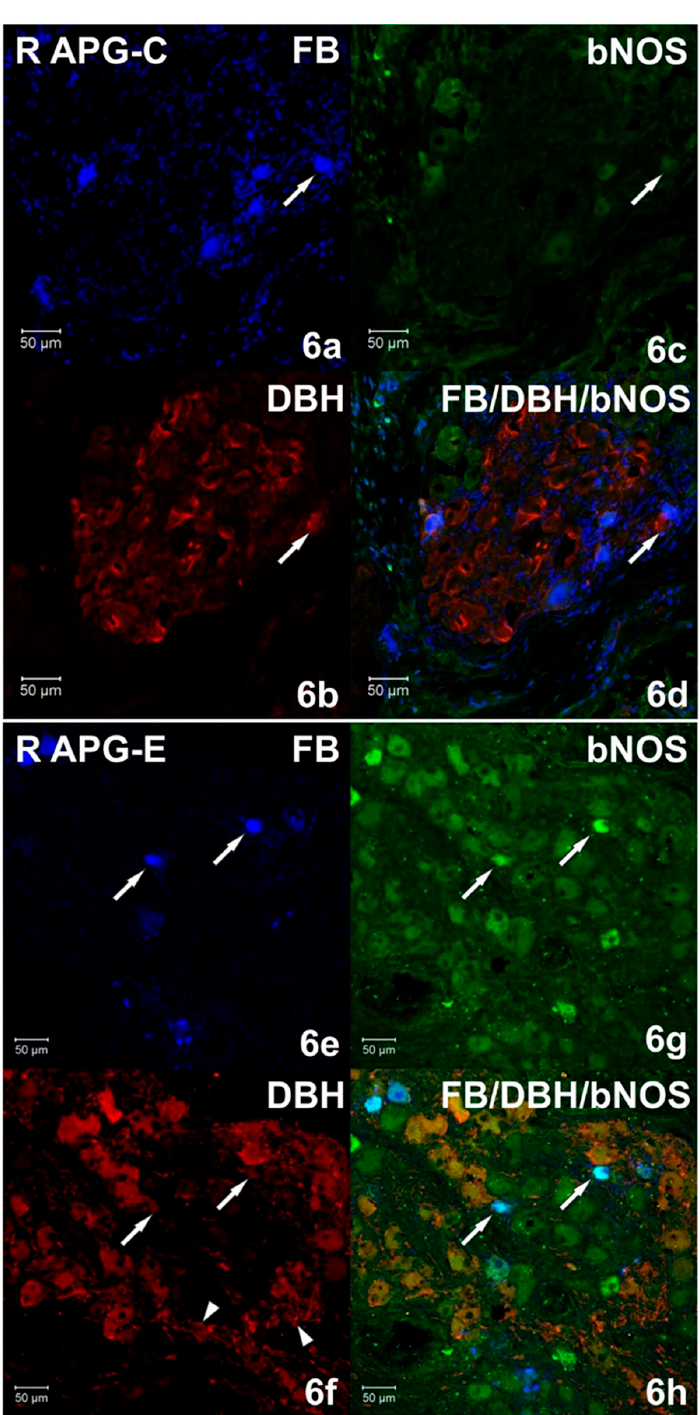
Figure 6. ( a – d ) Confocal laser scanning microscope images showing a section of the right (R) APG from the control (C) group. FB+ neurons ( a ) double-stained ( d ) for DBH ( b ) and brain nitric oxide synthase (bNOS) ( c ). The arrow marks an FB+ cell containing DBH but not bNOS. The images were taken from blue, green and red fluorescent channels. Blue, green and red channels were digitally superimposed. Scale bar = 50 µm. ( e – h ) Confocal laser scanning microscope images showing a section of the right (R) APG from the experimental group. Arrows indicate the FB+ ( e ) immunoreactive neurons against bNOS ( g ) and those not containing DBH ( f ). The arrowheads indicate a large number of DBH-IR ( f ) fibers. The images were taken from blue, green and red fluorescent channels. Blue, green and red channels were digitally superimposed. Scale bar = 50 µm.